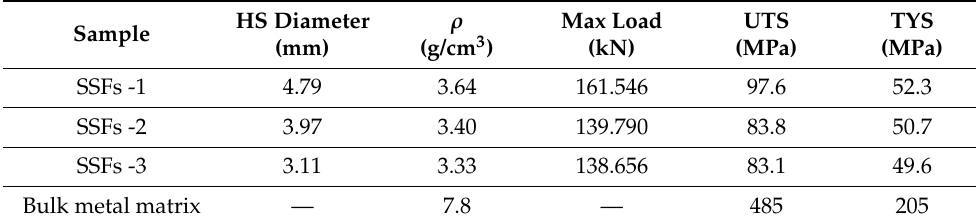
Table 3. Comparison of tensile properties between SSFs and solid metal.